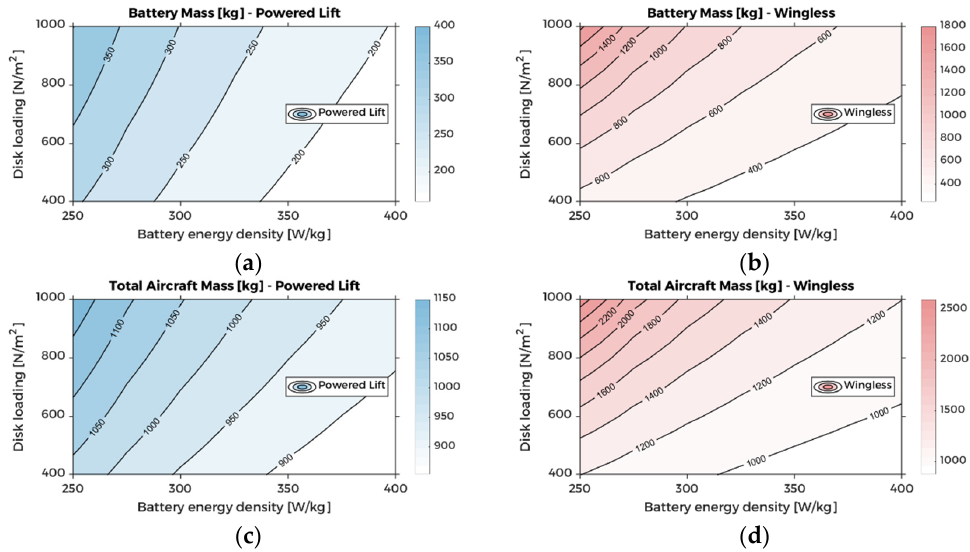
Figure 7. Battery energy density vs. disk loading sensitivity plots for ( a ) powered lift and ( b ) wingless propeller battery mass, and ( c ) powered lift and ( d ) wingless total aircraft mass.